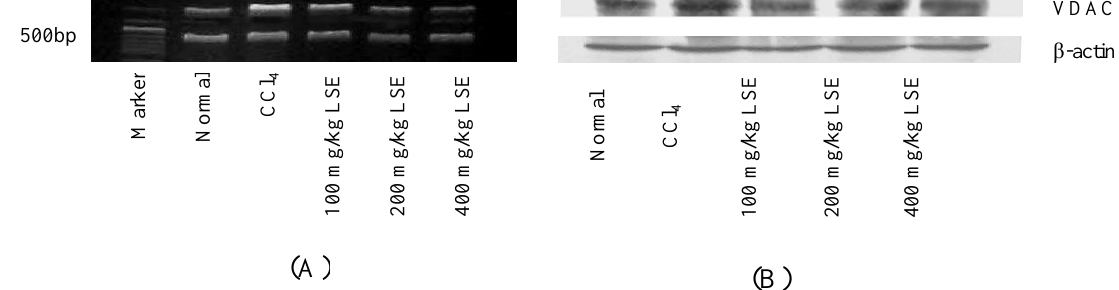
Figure 4. Effect of LSE on mitochondrial VDAC expression in CCl -insulted mouse livers. Mice 4 were divided into Normal, CCl , 100, 200, 400 mg/kg LSE groups. Livers from various group mice 4 were taken 18 h later. (A) Inhibitory effect of LSE on the increase in VDAC mRNA level induced by CCl , which was analyzed by RT-PCR. (B) Inhibitory effect of LSE on the increase in VDAC protein 4 level induced by CCl , which was analyzed by western blot. β -actin was used as a internal 4